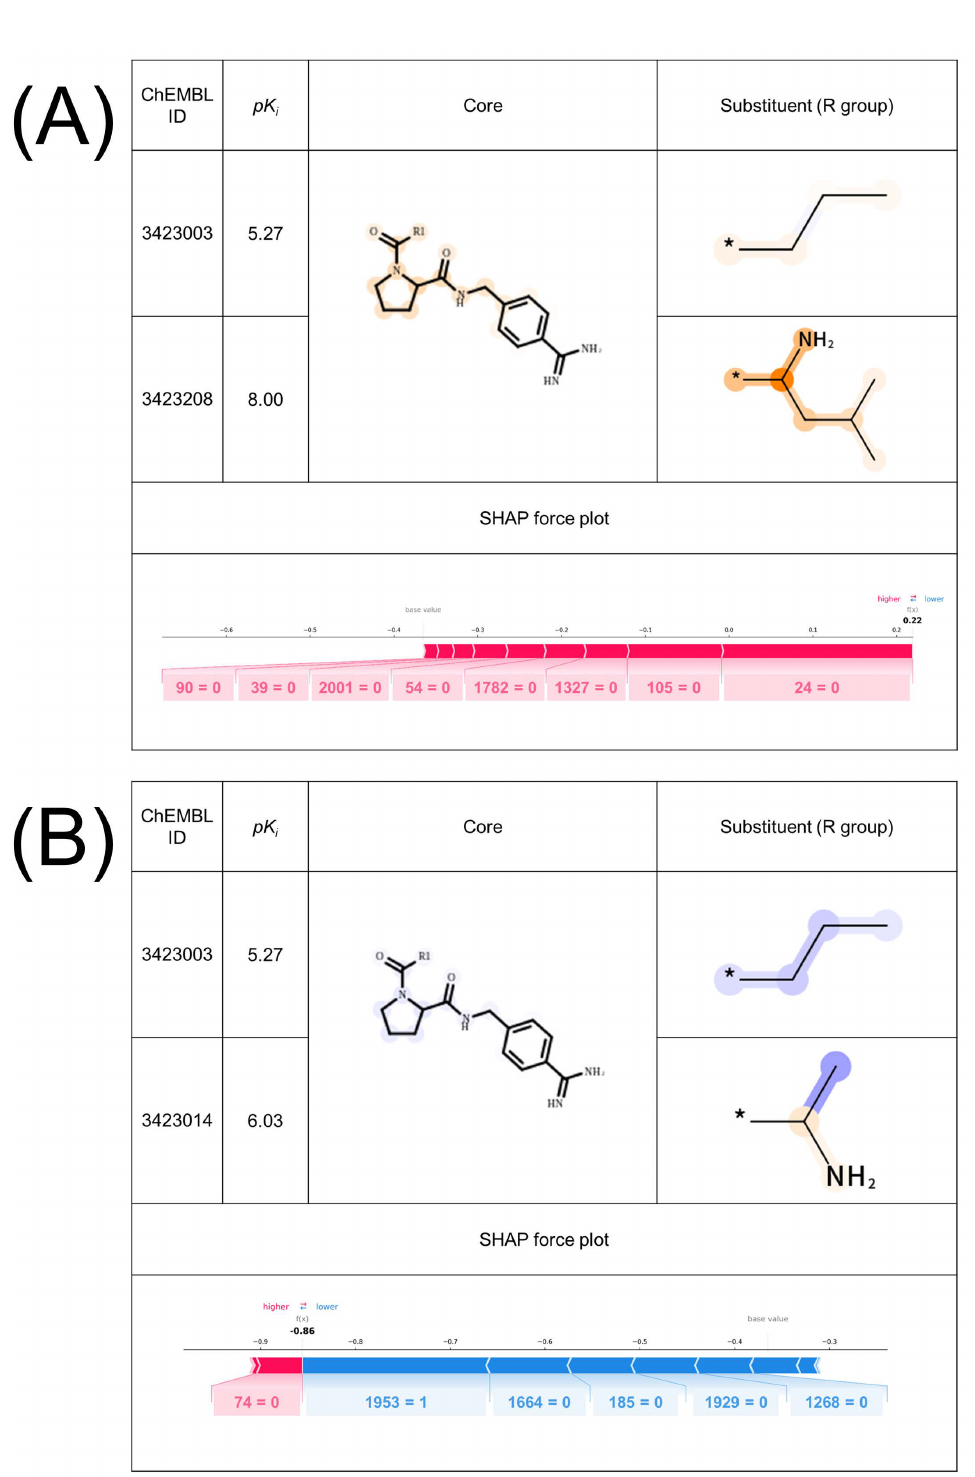
Figure 2. Comparison of the feature contribution mapping and SHAP for exemplary thrombin MMPs with an X-ray co-crystal structure predicted as TP and TN . Exemplary ( A ) TP and ( B ) TN MMPs of thrombin with the feature contribution map and SHAP force plot for the MMPs are shown. MMP ( A ) has an X-ray co-crystal structure. MMPs are formed by ( A ) ChEMBL3423003 and ChEMBL3423208, and ( B ) ChEMBL3423003 and